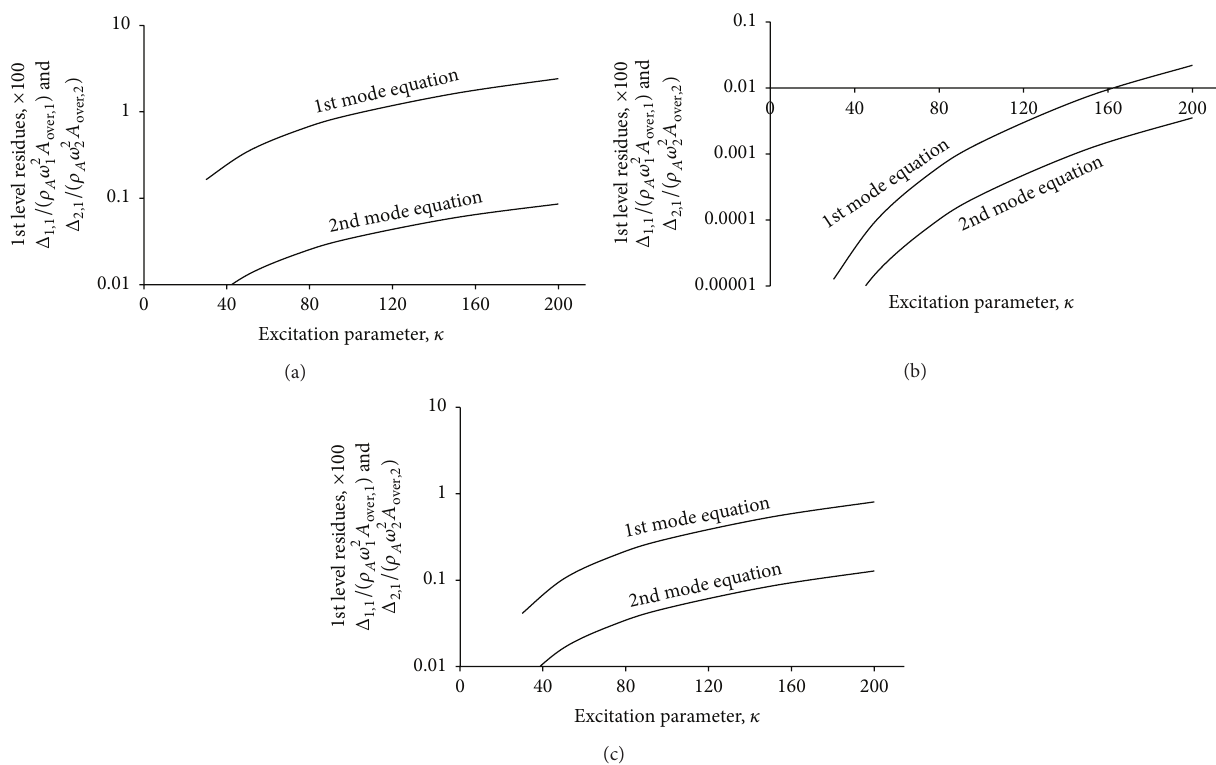
Figure 3: (a) The 1st level residues remained at the 1st and 2nd modal equations, 𝜔 = 𝜔 1 . (b) The 1st level residues remained at the 1st and 2nd modal equations, 𝜔 = 6𝜔 1 . (c) The 1st level residues remained at the 1st and 2nd modal equations, 𝜔 = 9𝜔 1 .